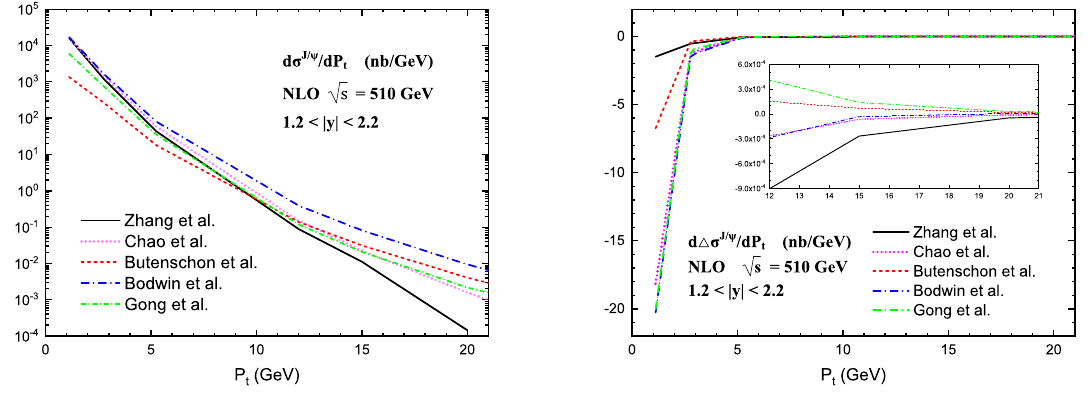
Figure 1 . The unpolarized (left-hand side) and polarized (right-hand side) cross sections of J/ψ direct production at √ s = 510 GeV up to QCD